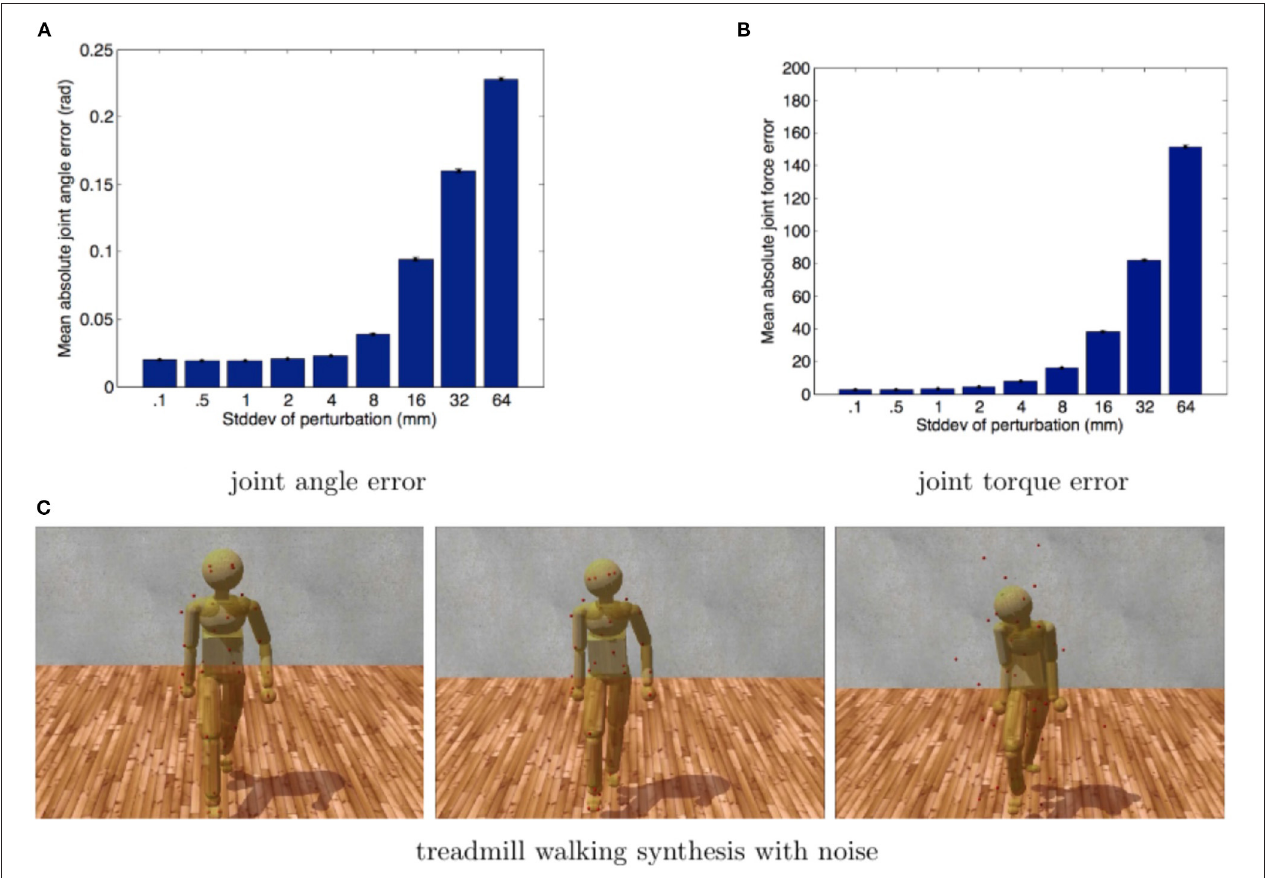
FIGURE 6 | Model noise sensitivity. The errors of joint angles and internal torques, resulting from physics-based inverse kinematics and inverse dynamics, are used to analyze perturbed marker data. We repeated the process twenty times for each noise level at nine different standard deviations. Standard-deviations, in mm, were (0.1, 0.5, 1, 2, 4, 8, 16, 32, 64). Error bars show the standard error of the mean. (A) The accuracy of the PhaseSpace motion capture device is ∼ 5 mm over its 3 × 6 m workspace, resulting in an average angular error of 1 ◦ . (B) The same estimates for torque error are between 5 and 10 Nm, typically ∼ 1%. These small errors are well within the requirements for our experiments. (C) Poses generated by forward dynamics using forces obtained from three inverse dynamics simulations based on Gaussian perturbed walking data (0.1, 8, and 64 mm noise levels). Although at very high noise levels, the model follows the reference motion poorly, the movement still looks, qualitatively, like